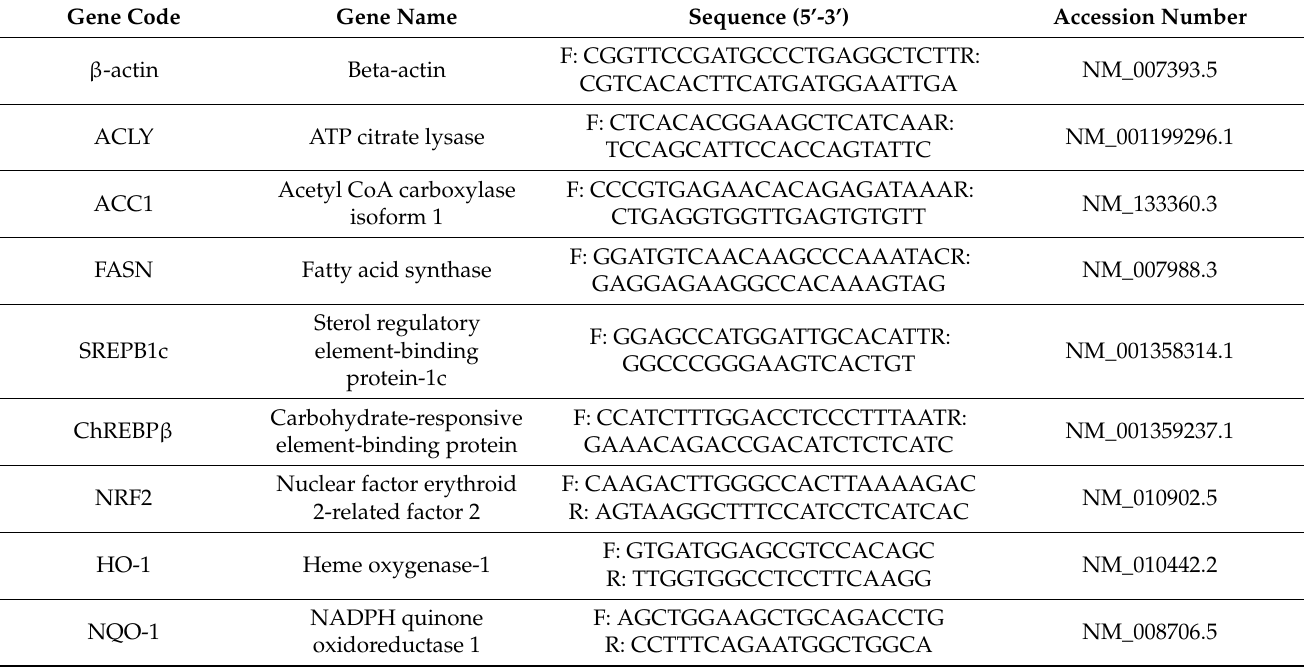
Table 1. The list of primers used in this